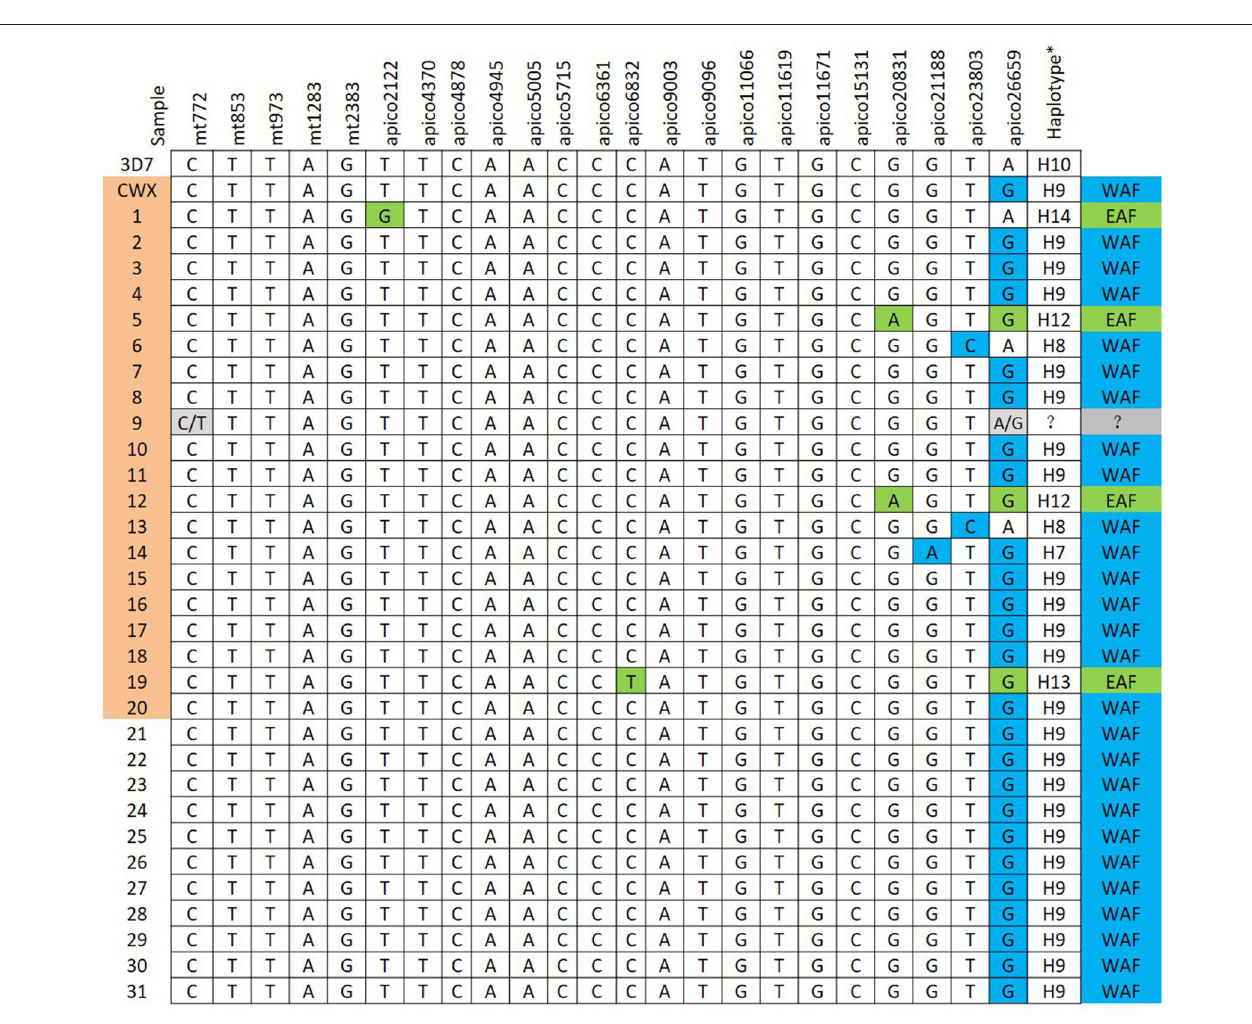
FIGURE 4 | Geographically informative barcode of Plasmodium falciparum mitochondrion and apicoplast genome single-nucleotide polymorphism (SNPs). The sample sequence results from the 23-SNP loci were compared to the geographically informative haplotype barcodes previously defined ( 7). WAF, West Africa; EAF, East Africa. Sample information: 18: Guinea, 19: Republic of Congo, 20: Sierra Leone; others originated from Equatorial Guinea. CWX and 1–20 samples marked with color were isolates with PfK13 mutation. *Haplotypes are based on the reference (